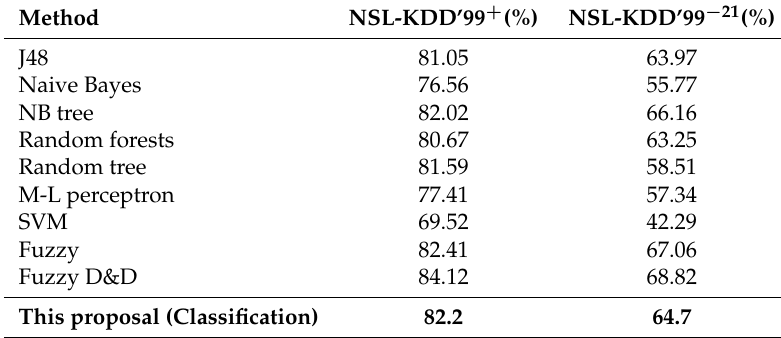
Table 11. Comparison with related works in terms of accuracy.